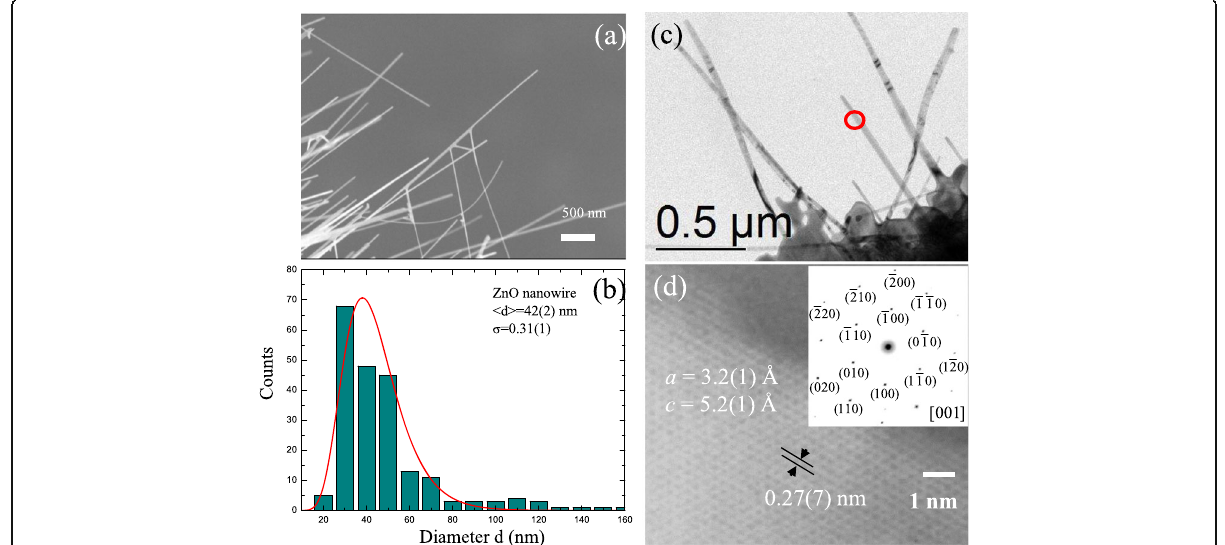
Fig. 1 a , b SEM image and diameter distribution for ZnO nanowires synthesized at 600 °C. c , d TEM image and high-resolution image of the selection region of ZnO nanowires. Inset displays a corresponding selected-area electron